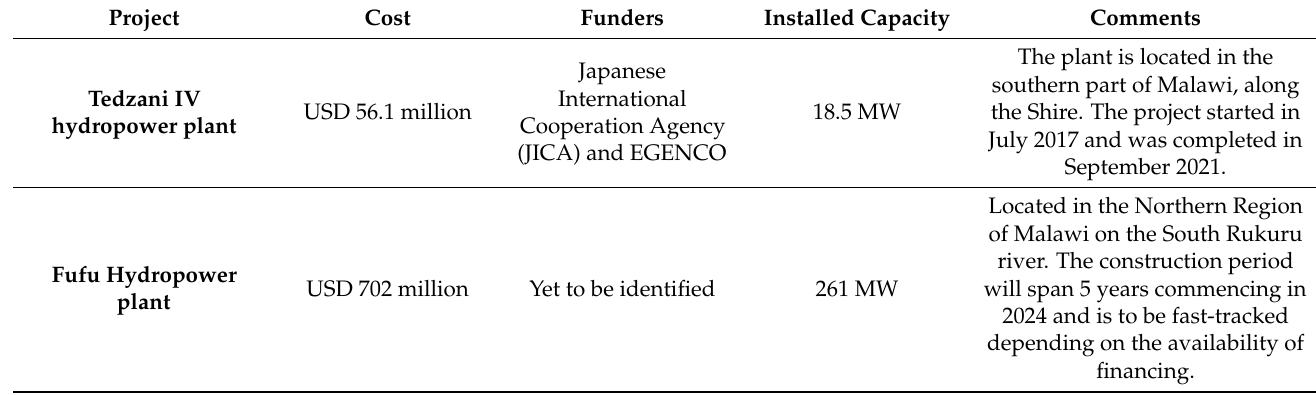
Table 3. Ongoing or earmarked capital investments in power generation projects (adapted from